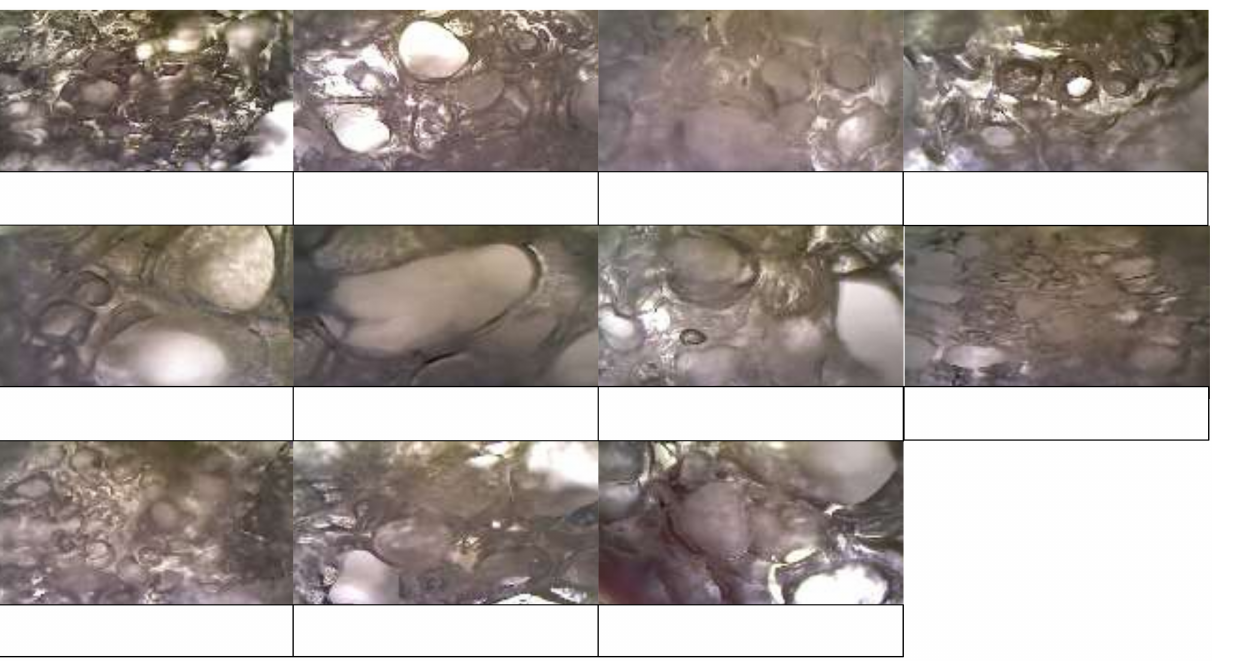
Figure 5. Microscopic structure of fried peanut coated with ozone-oxidized tapioca compared to native and H 2 O 2 -oxidized